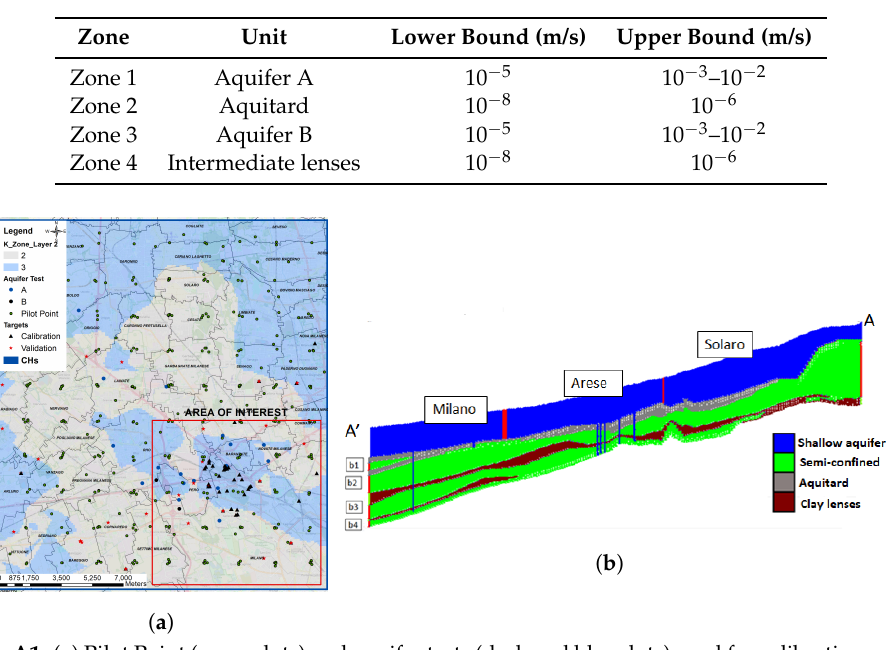
Table A1. Pilot Points upper and lower variability bounds, relative to the homogeneous zone to which they belong.